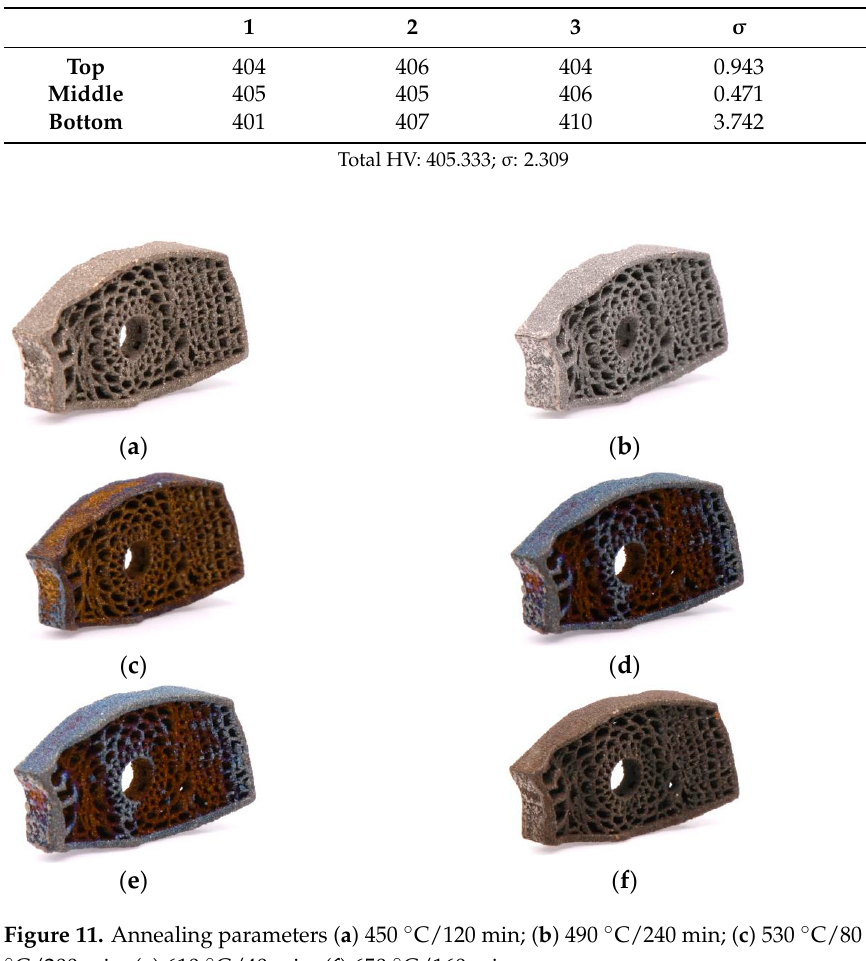
Table 10. The actual value of the optimal parameter.